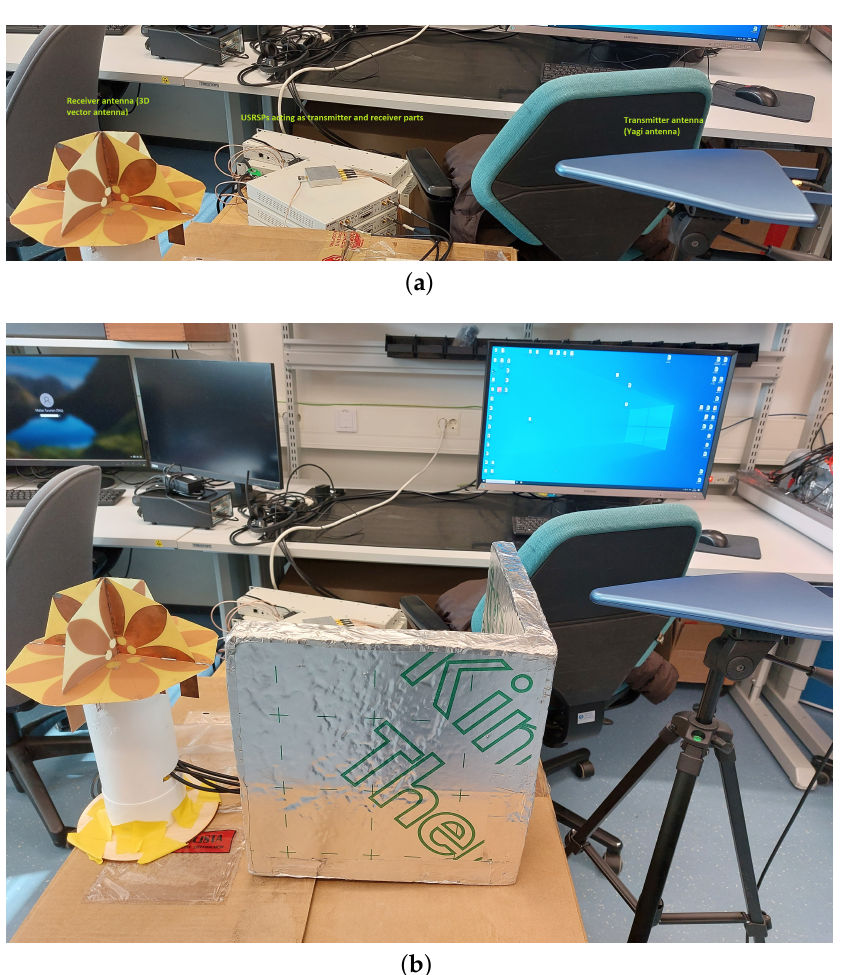
Figure 7. ( a ) LOS and ( b ) NLOS in-lab setup with 5G SRS signals, Yagi antenna at the transmitter and 3DVA at the